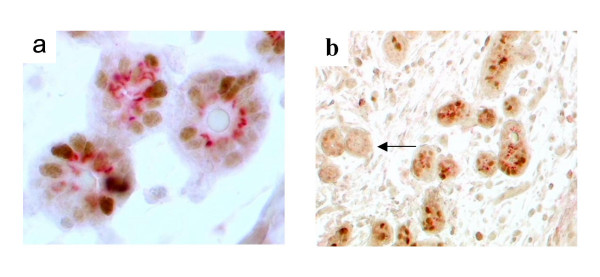
a, double staining of morphologically normal mammary epithelium: with anti DMBTh12 Ab (red stain in the cytoplasm) and with anti MCM5 Ab (Brown stain in the nucleus); b, lower magnification of double labelled mammary tissue; arrow points to a structure negative for both antigens.